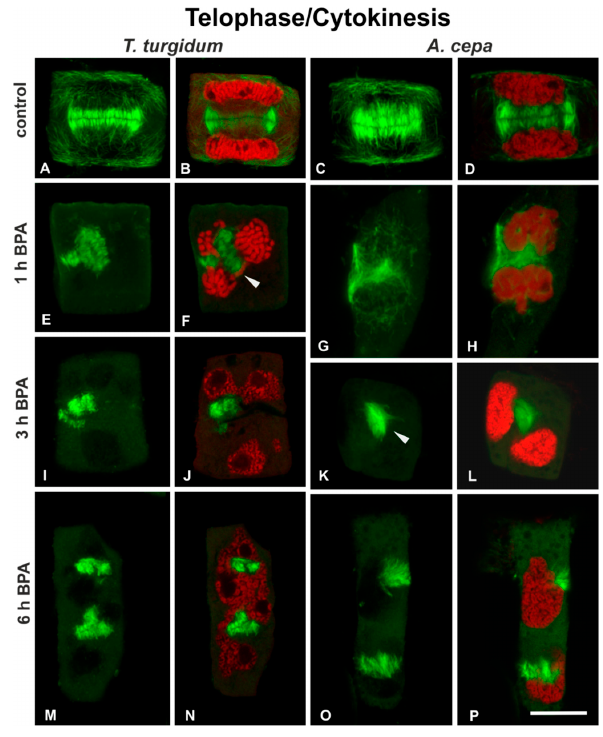
Figure 5. (A – P ) Tubulin immunolocalization (green) and ( B , D , F , H , J , L , N , P ) propidium iodide DNA staining (red) in telophase/cytokinetic root cells. Arrowhead in ( F ) points to a lagging chromosome arm, while arrowhead in ( K ) points to unexpanded phragmoplast. Note the extensive presence of branched phragmoplast conformations ( E – J , M , N ). ( A , C , E , G , H , I , K , M , O ) Maximum projections of CLSM sections; ( B , D , F , J , L , N , P ) single sections. Scale bar: 10 μ m. To sum up, in both plant species, BPA treatment was fatal for the cell cycle: depending on the exact stage, in which each cell was entering while affected by BPA, the chromosomes failed to aggregate at the metaphase plate, to segregate and move to opposing poles at anaphase (Figure 4I-L) and to form the new nuclei at telophase, while cytokinesis was dramatically disrupted (Figure 5E-P). Since typical bipolar spindles were not organized under BPA treatment, metaphase could not be distinguished from anaphase in most mitotic cells. 3.2. Combined Treatments with Anti-Microtubule Drugs and BPA In order to decipher the possible role of microtubule dynamics in their response to BPA, we performed combined treatments with oryzalin (microtubule depolymerizing) or taxol (microtubule stabilizer) and BPA. T. turgidum root cells firstly treated with 5 μΜ oryzalin for 12 h and then left to recover in water for 12 h bore densely arranged but largely misaligned cortical microtubules (Figure 6A). When seedlings were first exposed to 5 μ M oryzalin and then to 50 mg/L BPA for 12 h, they exhibited bundles of curly, wavy, and ring-like cortical tubulin structures (Figure 6B), resembling those encountered in BPA-affected interphase cells of A. cepa ( cf. Figure 1G, H).